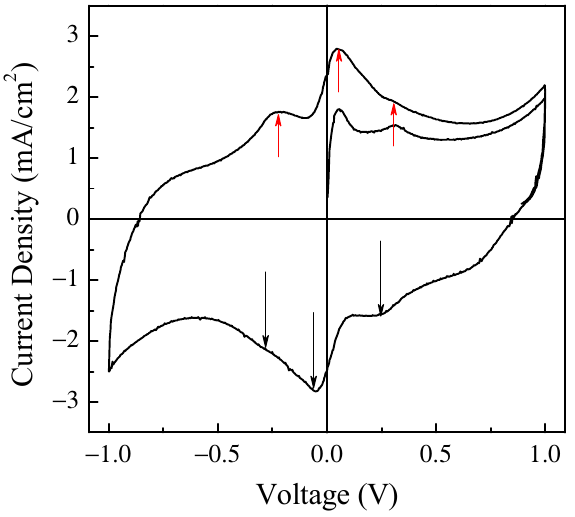
Figure 8. Transient phase and current density–voltage loop of a typical Au/PPy:DBSA/Nafion:LiPs/PPy:DBSA/Au cell in response to 1V amplitude triangular voltage pulses with a 300 s period and corresponding to a scan speed of ~13.3 mV/s. The current density through the device was measured in response to zero average triangular voltage pulses with a 1 V amplitude and period of 300 s, which corresponds to a voltage time rate of change of about ± 13.3 mV/s. After a transient phase, the current density starts to cycle, resembling a fairly symmetrical clockwise loop that reflects the symmetry of the device and that is far from the rectangular shape expected in the case of EDLCs. Two forward current density peaks and a shoulder, which were recorded while the voltage linearly increased with time and that can be identified by the red arrows in the figure, are observed at about − 217 mV, 51 mV, and 297 mV. Two reverse current density peaks and a shoulder, which were recorded while the voltage linearly decreased a function of time, are identified by the black arrows and can be found at approximately 203 mV, − 54 mV, and 281 mV. It is well known that the current–voltage loop of a capacitive device changes with the absolute value of the voltage’s time rate of change, namely with the scan speed, in a way that is related to the kind of mechanisms from which the capacitance of the device originates. In fact, the current intensity is expected to be a linear function of the scan speed in EDLCs, while the relationship between the intensity of the current peaks and the scan speed, though not necessarily linear, can provide useful information concerning the redox processes at the electrodes. Figure 8 shows the results of the current density–voltage measurements performed at different scan speeds on the same Au/PPy:DBSA/Nafion:LiPs/PPy:DBSA/Au that Figure 8 refers to. It is worth noticing that the cycles of Figure 9 have the same well-defined current density peaks that are commonly observed when electrodes are tested in an electrolytic solution rather than in a solid-state configuration, as in our case. The presence of the current density peaks when in a solid-state configuration could be related to the role played by DBSA: in fact, the efficiency of the ion diffusion onto the PPY surface may be facilitated in the presence of the finer polymer granules achieved by dispersing PPY into the surfactant and the surfactant, though not covalently bound to the surface of the PPy granules, may electrostatically affect the space charge distribution at the electrodes. It can be noticed that the position of the current density peaks change slightly with the scan speed and that the area enclosed in the current density loops increases as the scan speed increases. Figure 10a shows that the absolute maxima and minima current density, recorded in correspondence to the couple of peaks marked in Figure 9 as A and B, are a linear function of the square root of the scan speed. This kind of relationship is a characteristic feature of the diffusion- limited irreversible redox processes occurring at the electrodes. On the other hand, in the voltage region where the loop current density is relatively flat (see the black vertical